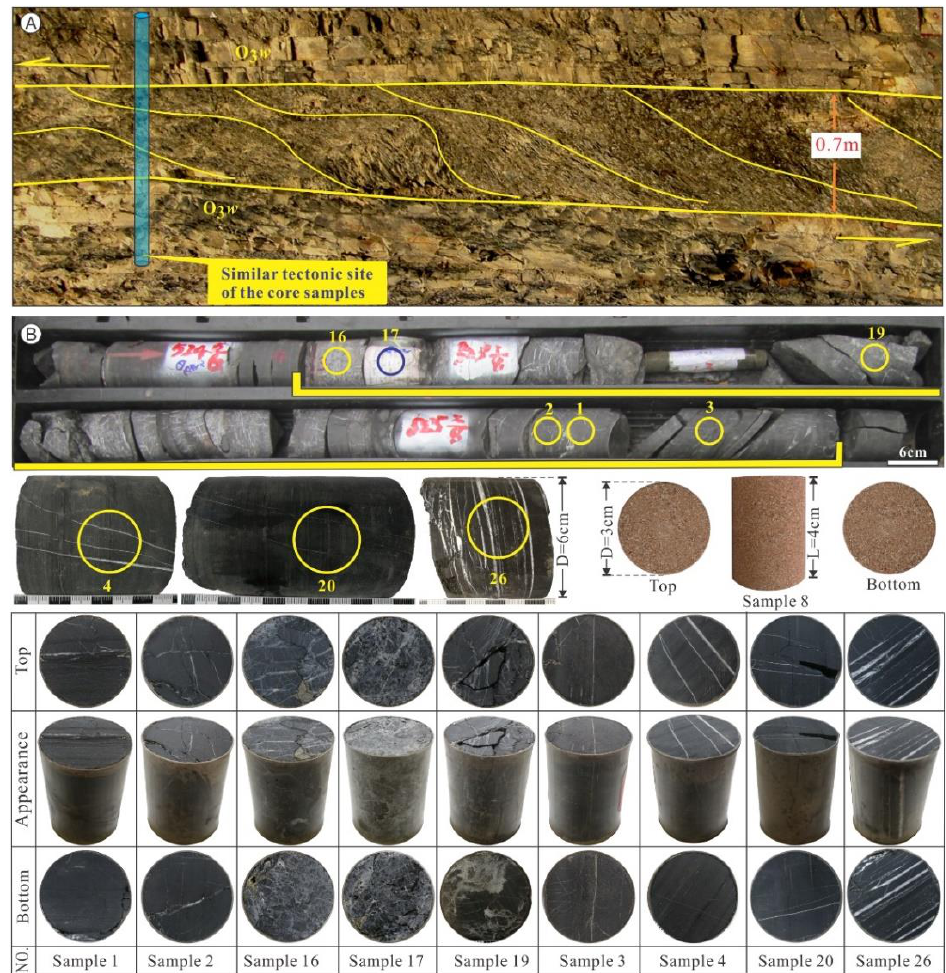
Figure 1. ( A ) Outcrop of a regional fault in shale strata in Chongqing municipality constituting a similar tectonic site to that of the core samples from well HD-1 used in this study; ( B ) images of well HD-1 cores and the 10 (i.e., 9 shale and 1 sandstone) samples used for permeability